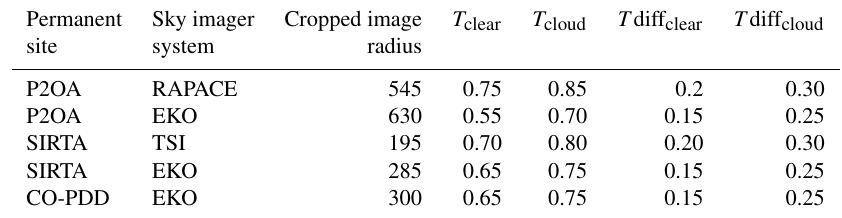
Table 3. Thresholds used in step 4 for the different systems of the ACTRIS-FR instrumented sites.